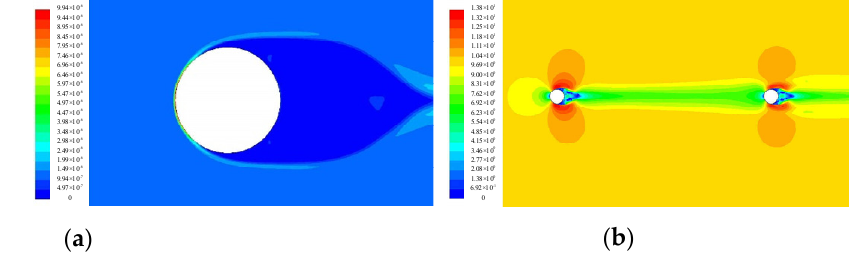
Figure 16. Gas–liquid two-phase flow characteristics of ice-covered DEC and double-bundled conductors. ( a ) DEC. ( b ) Double bundled conductors.